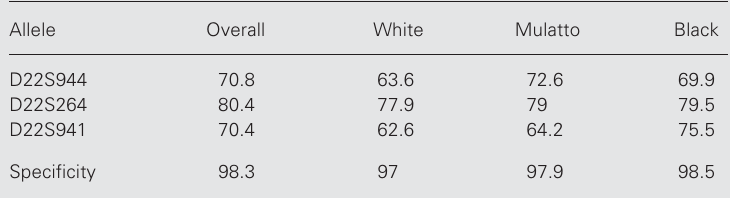
Figure 2. Assay specificity in re- lation to the number of markers assayed. Note that specificity does not increase significantly after addition of a fourth marker to the test.